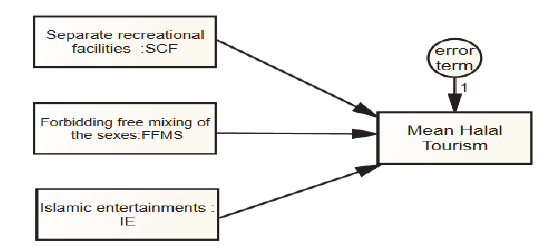
Fig. 3. Impact of Muslim friendly Holidays on Halal Tourism Fig. 4. Impact of Misc. Islamic factors on Halal